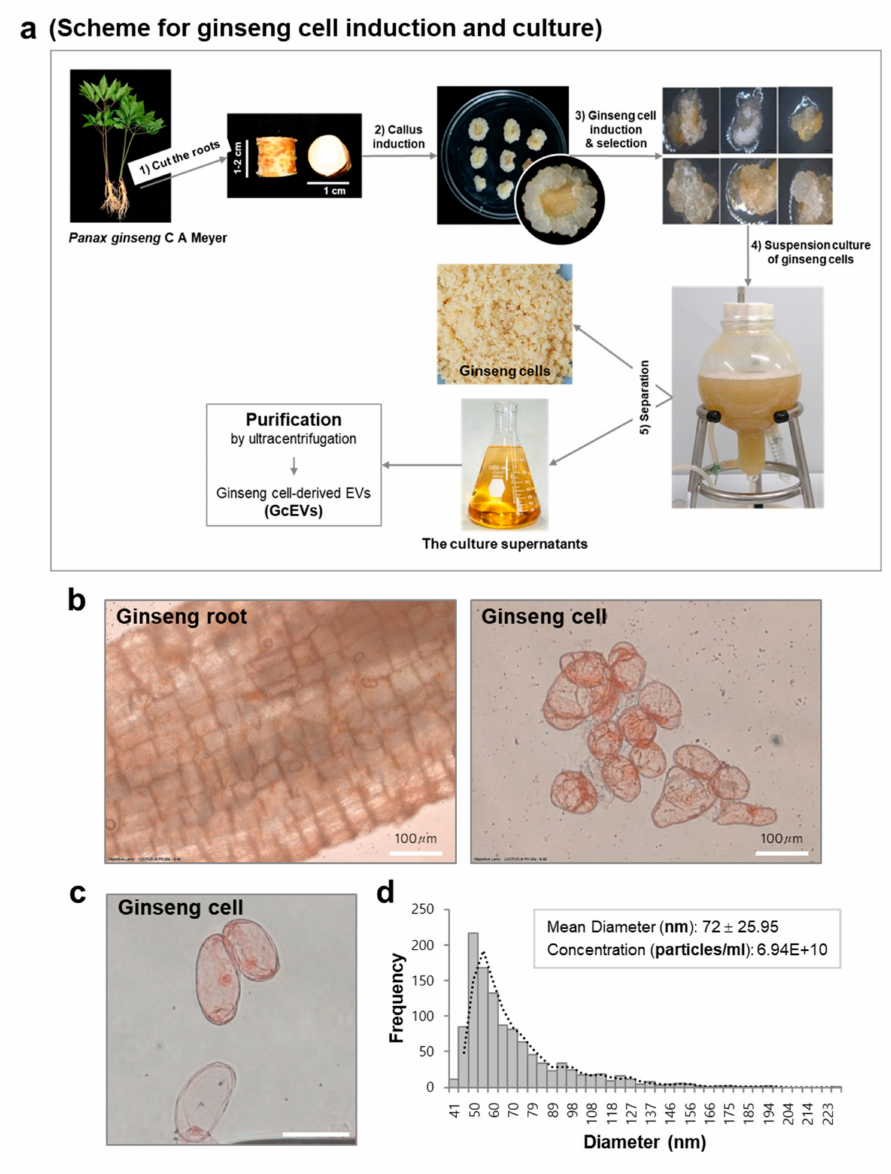
Figure 4. Isolation and characterization of ginseng cells and ginseng cell-derived EVs (GcEVs). ( a ) Di- agrammatic representation of the process for isolating and culturing ginseng cells. After isolating ginseng cells from ginseng roots and culturing them in suspension for two weeks, GcEVs were puri- fied from the culture supernatants by a conventional ultracentrifugation method. ( b ) Representative phase–contrast images of ginseng roots and ginseng cells. Scale bars, 100 µ m. ( c ) Representative phase–contrast image of ginseng cells in culture. Scale bar, 100 µ m. ( d ) The diameter and the particle number of GcEVs were analyzed by tunable resistive pulse sensing after